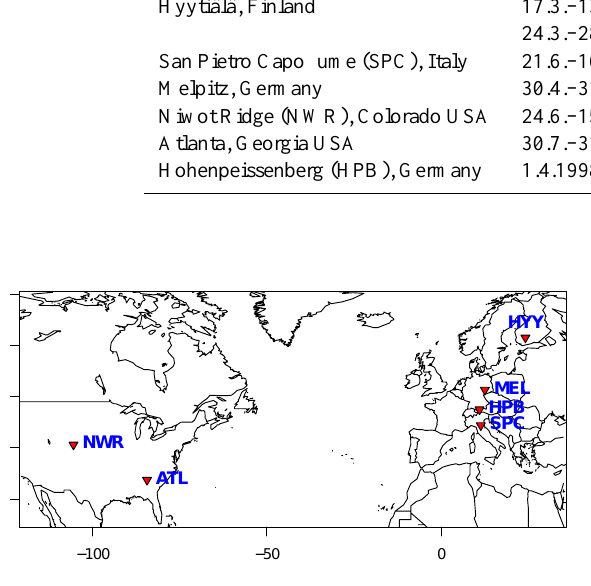
Fig. 1. Locations of the six observation sites for tropospheric sul- phuric